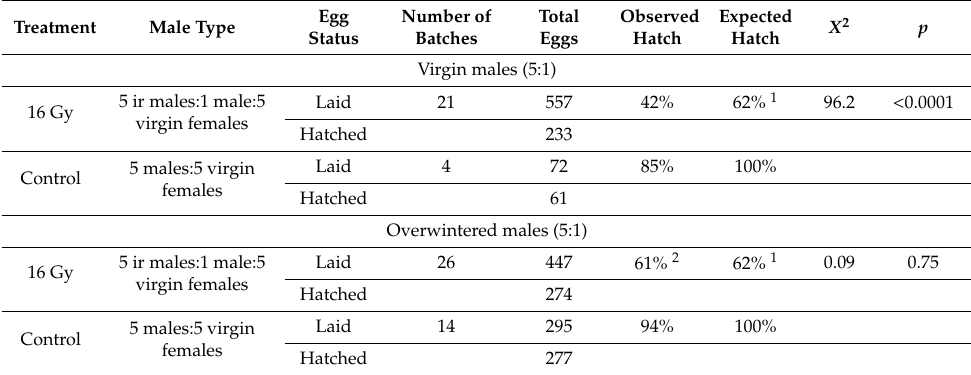
Table 2. The e ff ect of male irradiation on Halyomorpha halys egg hatch from five-to-one ratios of irradiated (ir, 16 Gy) and untreated virgin male parents placed with five virgin females, compared with untreated controls and overwintered males with the same treatments.